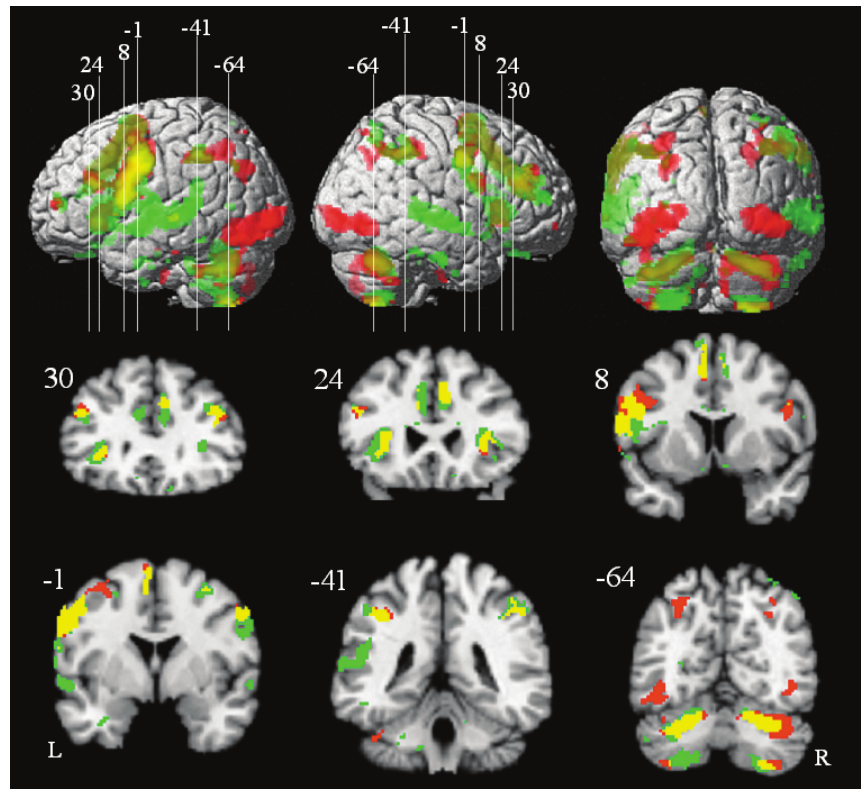
Fig. 3. Brain activation as a function of modality and working memory load. Red regions represent voxels that exceeded statistical significance threshold for the visual but not for the auditory modality; green regions represent voxels that exceeded threshold for the auditory but not visual modality; yellow regions exceeded threshold in both modalities. Voxels have been thresholded at p < 0.001, and all survived false discovery rate correction at p < 0.05. Numbers on the figure indicate distance in mm from the Y axis origin of the MNI